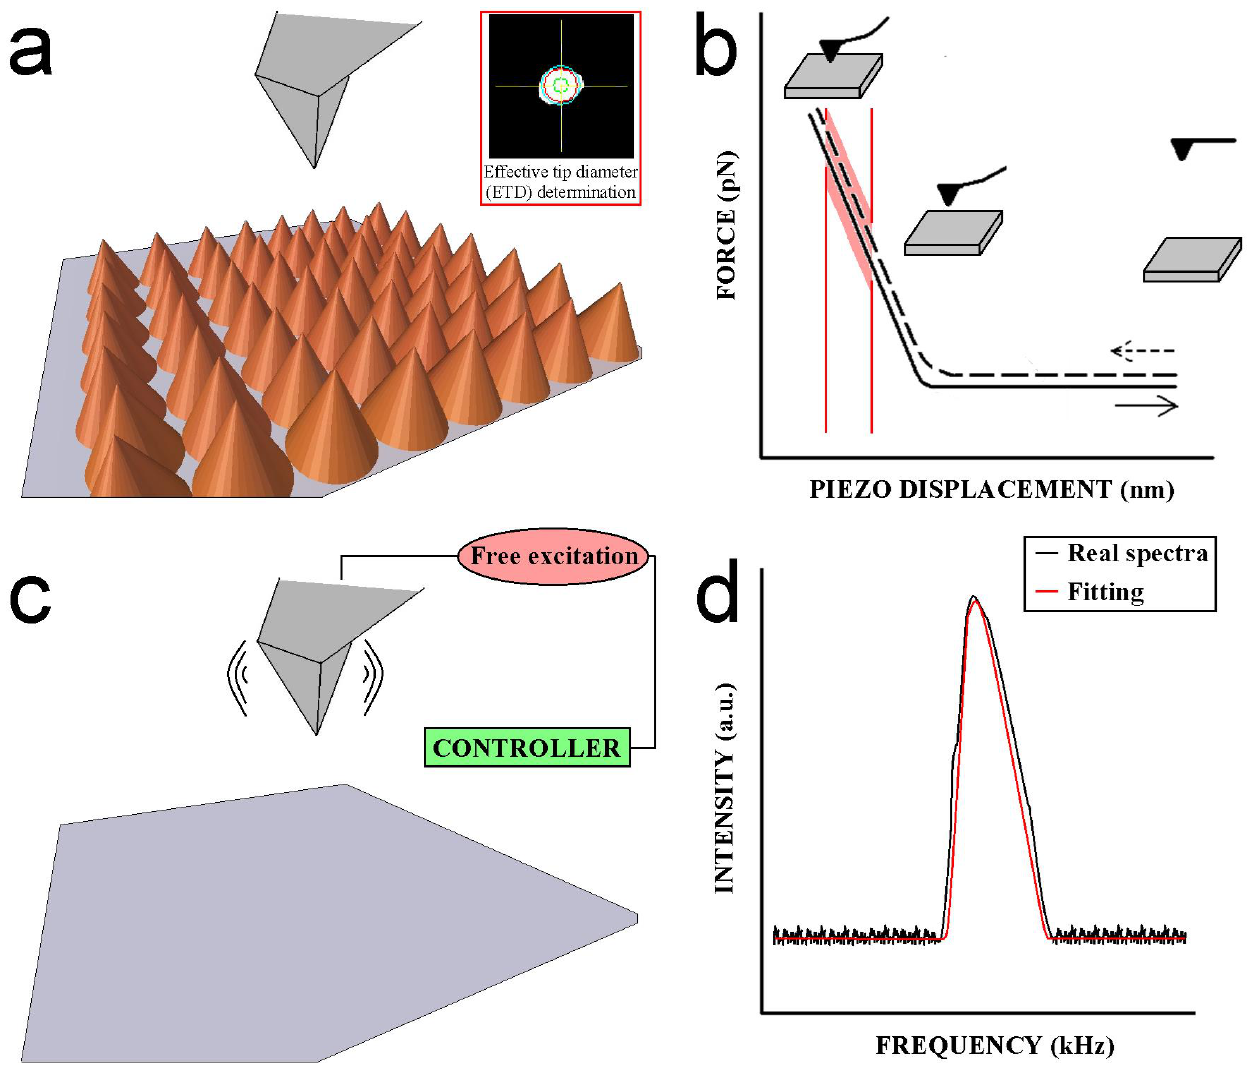
Figure 3. Schematic representation of ( a ) AFM tip radius quantification. The inset depicts the convolution performed to get the geometry and dimensions of the tip apex. ( b ) Typical force-curve acquired on stiff solid surfaces. The region comprised by the two red lines indicates the slope taken into account to calculate the AFM cantilever deflection sensitivity. ( c ) Brownian movement of the AFM cantilever when it is free of excitation. ( d ) Representative spectrum obtained by frequency sweep. The black line represents the raw experimental data, and the red line represents the fitting curve using simple harmonic oscillator